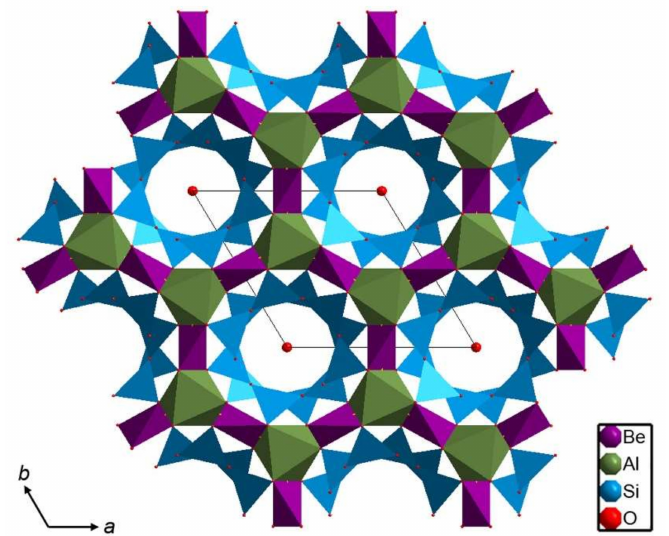
Figure 1. The beryl structure (based on [12]) with the framework structural sites pictured as coordination polyhedral and channel sites located at the center of each six-membered tetrahedral ring indicated by a red